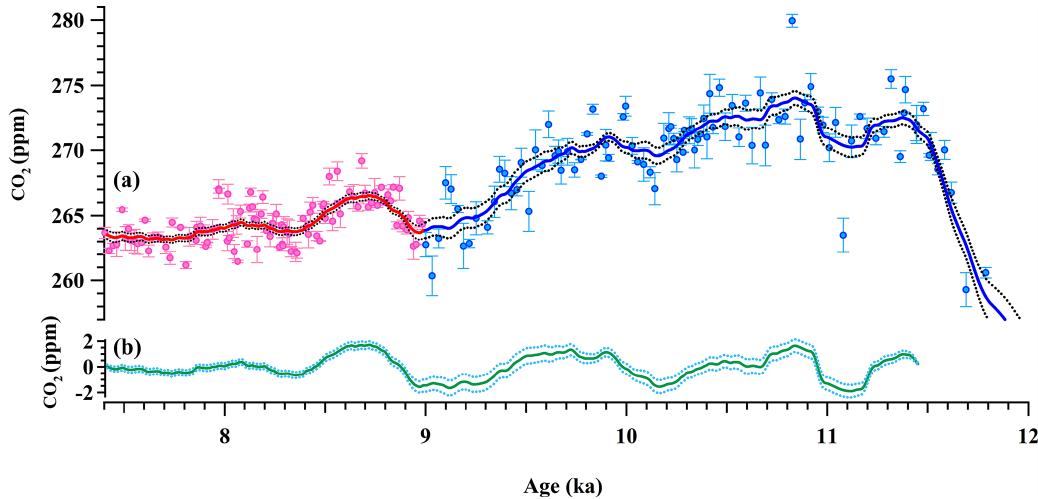
Figure 1. High-resolution atmospheric CO 2 records obtained from Siple Dome ice core, Antarctica, during the early Holocene. (a) Pink and blue circles are Siple Dome ice core records obtained at Oregon State University (Ahn et al., 2014) and Seoul National University (this study), respectively. Lines represent 250-year running means, and dotted lines represent 2 σ uncertainties calculated from Monte Carlo simulation. For the simulation, we produced 10000 different sets of CO 2 concentrations which vary randomly with Gaussian propagation in their uncertainties. (b) The green line indicates 250-year running means of the original Siple Dome CO 2 data processed by high-pass filtering at 1 / 1800yr − 1 . The blue line indicates 2 σ uncertainties of the 250-year mean value and cannot be used to interpret variations on shorter timescales.